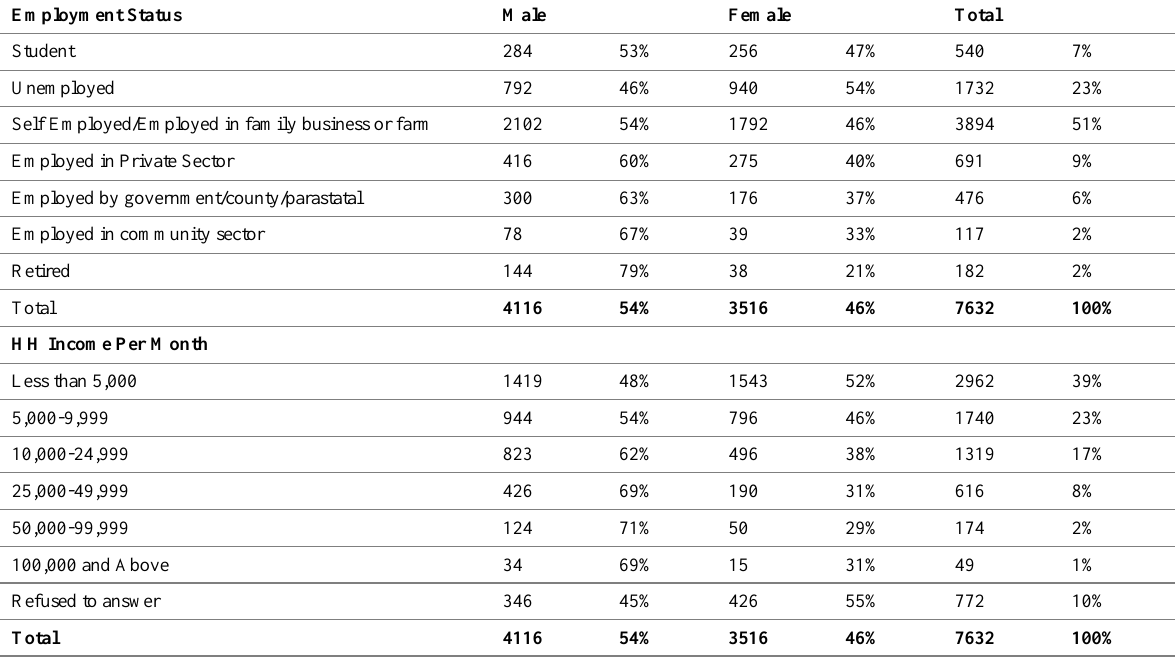
Table 4: Citizen's employment status and monthly HH income by sex (N=7632)